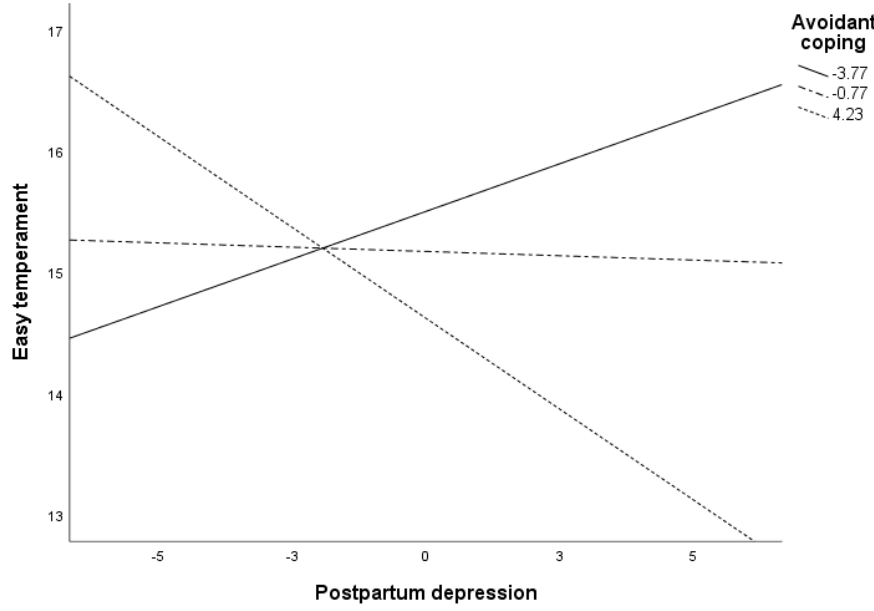
Figure 2. Conditional effects of PPD on perception of baby with easy temperament at values of avoidance.